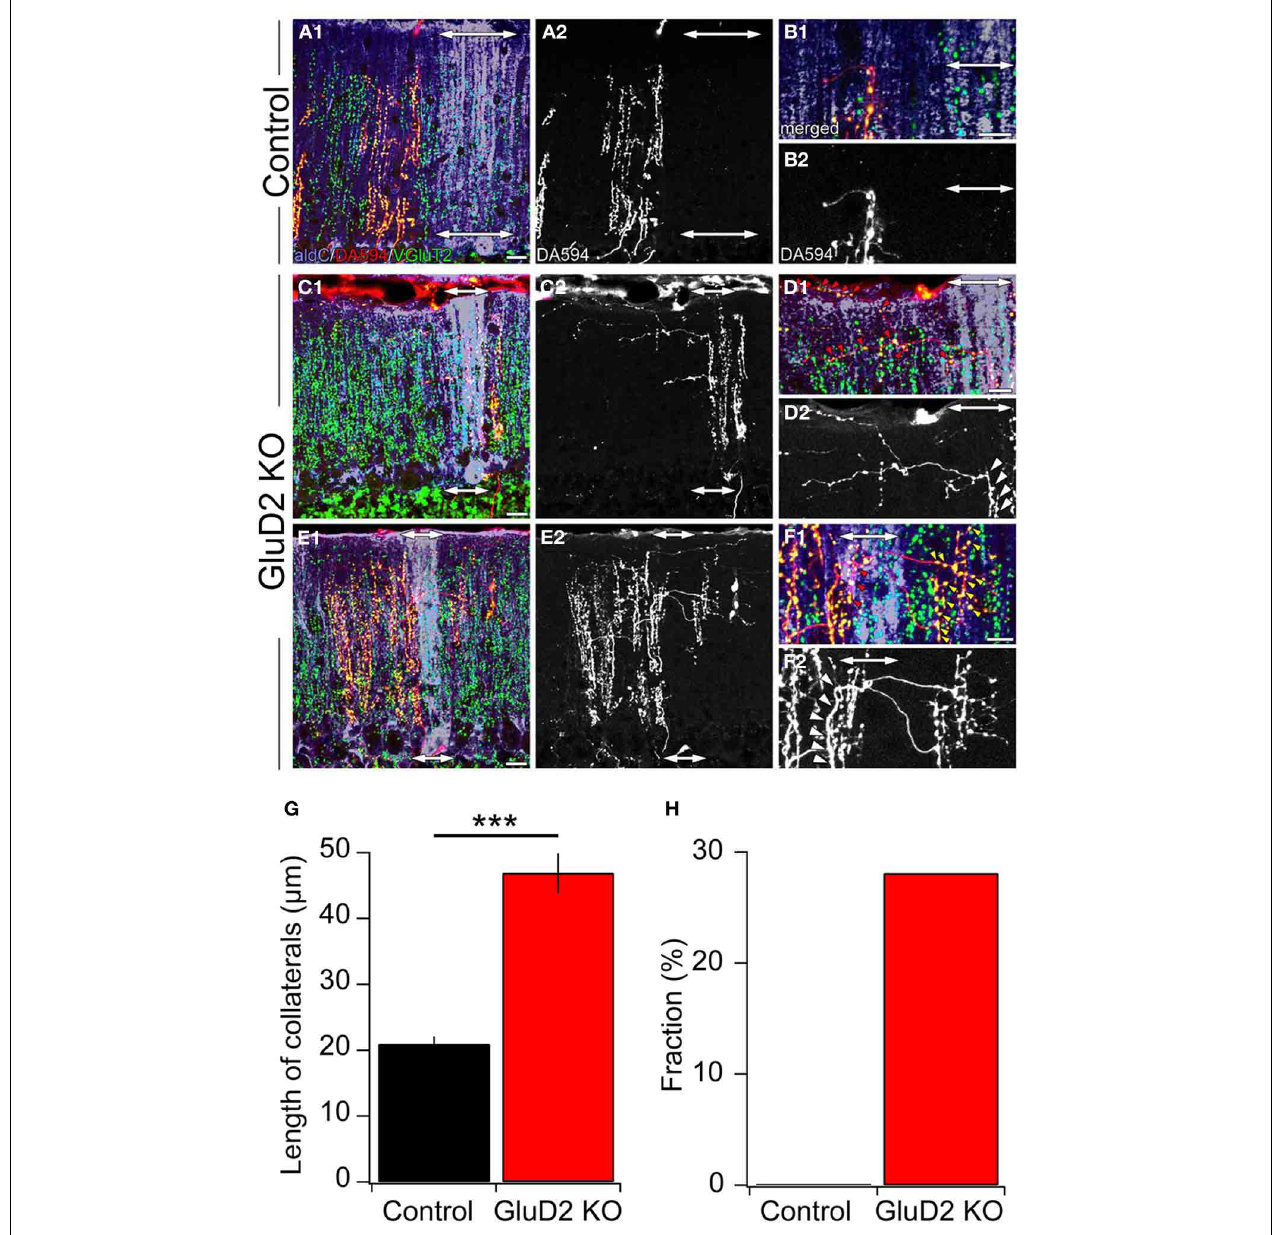
FIGURE 5 | Ectopic CF innervations beyond the zones in GluD2 KO mice. (A) Photomicrographs of a horizontal section of cerebellar cortex from a control mouse. In (A1) , aldC (purple) and VGluT2 (green) positive structures are present beside CFs labeled with DA594 (red). Double-headed arrows indicate the region in which aldC-positive PCs are localized. In this case, the tracer was taken up by CFs projecting to an aldC-negative zone. (A2) is the same section as (A1) but shows DA594-labeled CFs only. (B) Magnified pictures of the outer molecular layer near the pial surface in (A1) and (A2) . There are short transverse CF collaterals that lack VGluT2-positive puncta and do not reach the adjacent aldC-positive zone. (C) Photomicrographs of a horizontal section of cerebellar cortex from a GluD2 KO mouse. In this case, transverse CF collaterals bifurcate from ascending CFs that project to aldC-positive PCs. Note that transverse CF collaterals extend toward the adjacent aldC-negative zone. (D) Magnified pictures of the outer molecular layer near the pial surface in (C1) and (C2) . Red arrowheads in (D1) indicate VGluT2-positive